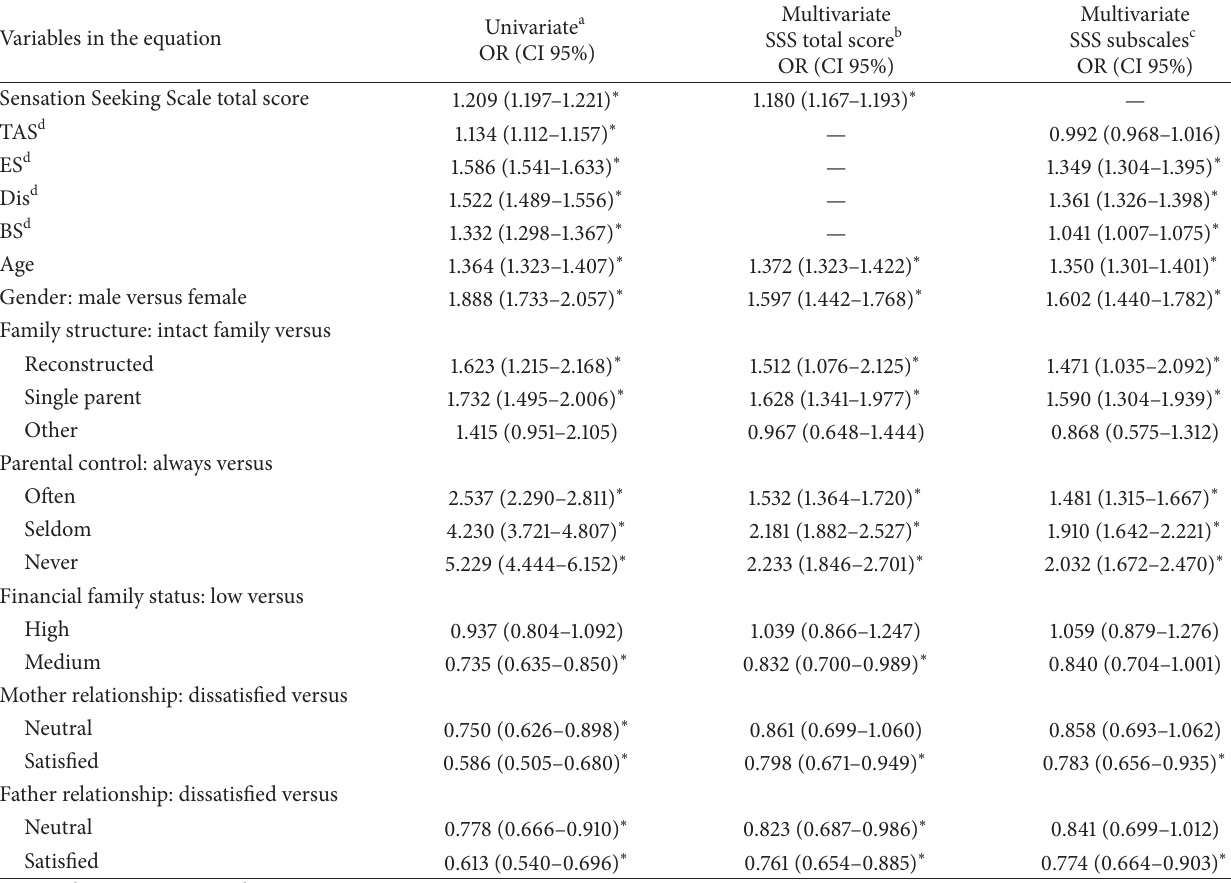
Table 4: Binary logistic models for substance use (Models 1, 2, and